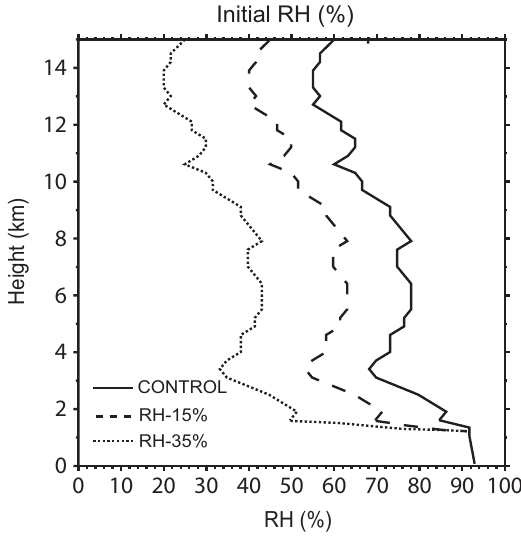
Fig. 4. Vertical profiles of initial RH. Fig. 5. Time series of the area-averaged precipitation